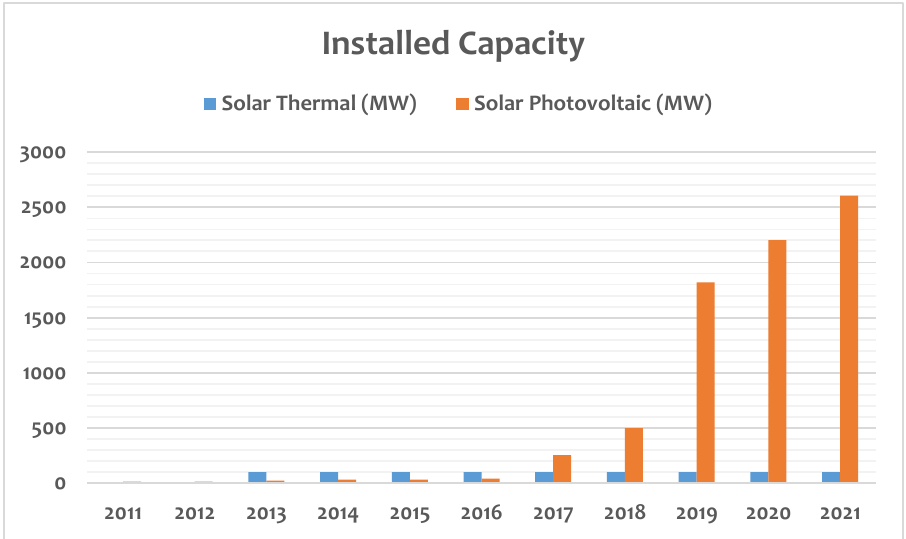
Figure 3. UAE solar energy generation installed capacity (2011 – 2021). Data were collected from [14].